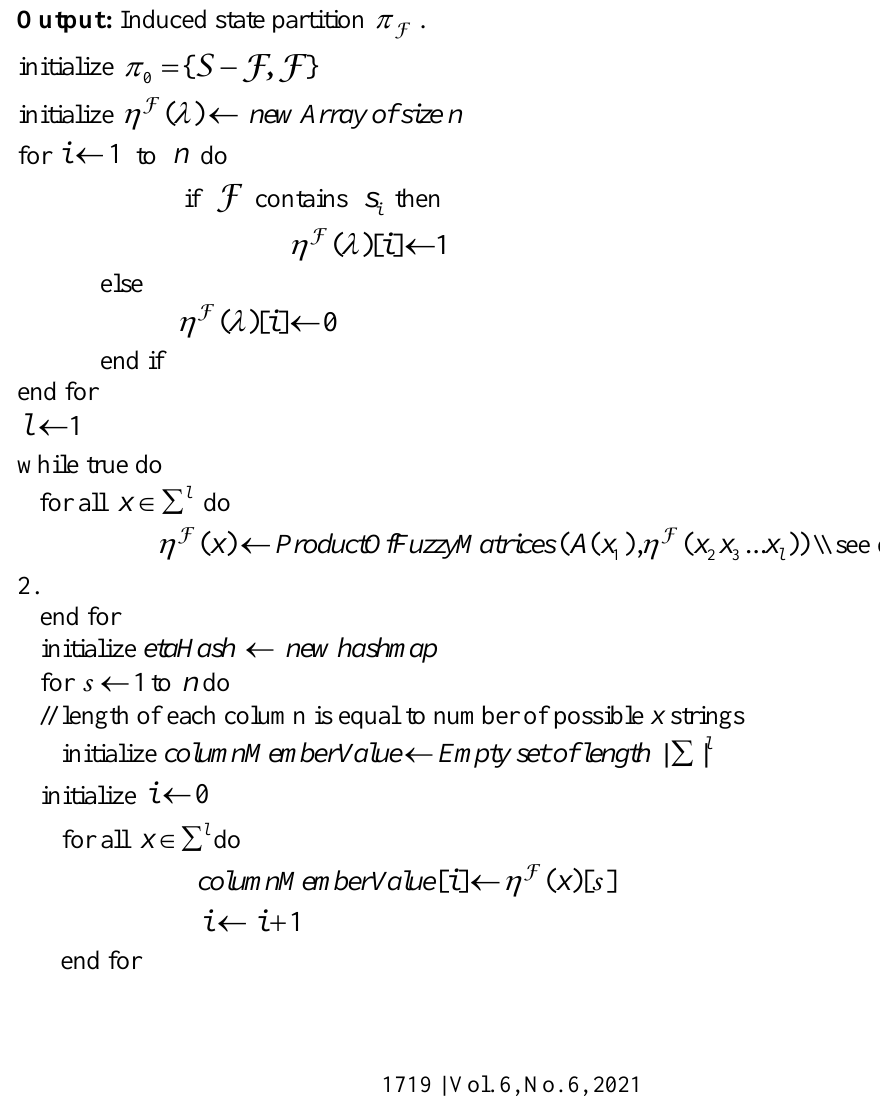
Algorithm 4.2 Pseudo